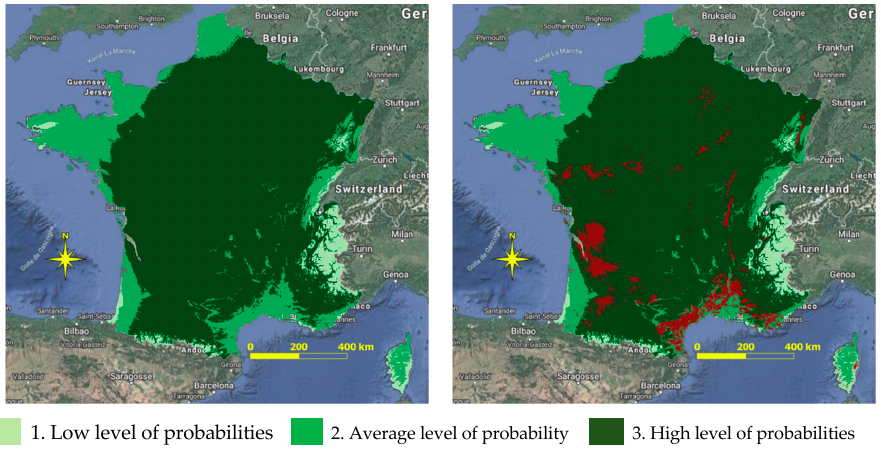
Figure 7. Potential suitable areas for grapevine crop according to RCP 6.0 climate scenario for 2050. Grapevine crops declared in 2018 are represented in red.